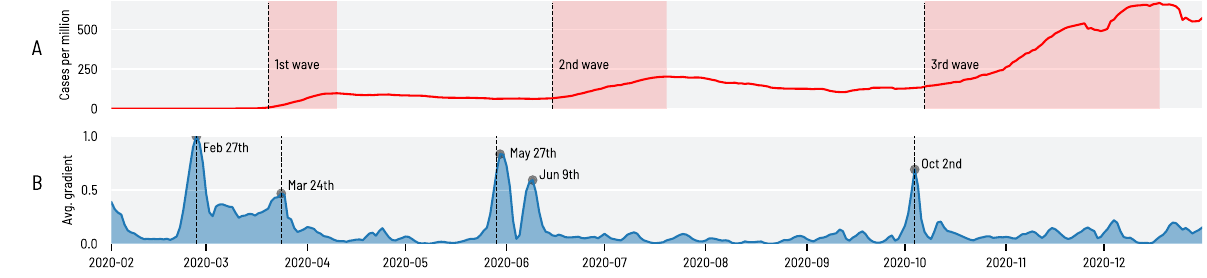
Fig. 2 Variation of the language categories over time. The number of recorded infections in the U.S. ( A ), and the average gradient (i.e., instantaneous variation) of all the language categories ( B ). There were three contagion waves in the year (shaded areas in A ) and, for each wave, there were peaks in the gradient (marked with circles in B ), which identify change-points , that is, periods in which the use of language considerably changed.